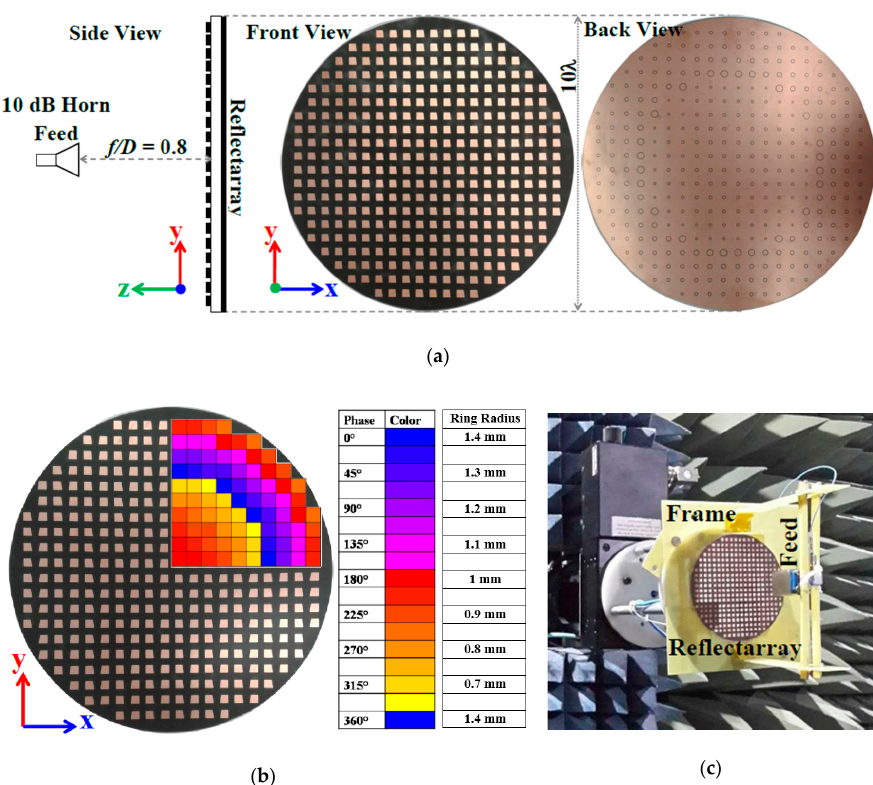
Figure 8. Asymmetric patch reflectarray antenna: ( a ) Non mirror orientation of elements and ground ring slots; ( b ) Mirror orientation of elements; ( c ) During measurements. Electronics 2020 , 9 , x FOR PEER REVIEW